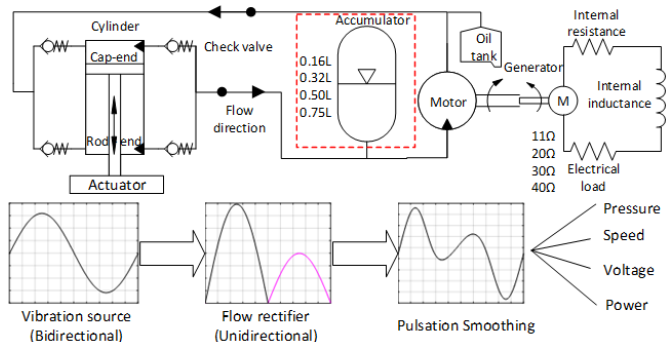
Figure 1. Schematic view of the design concept for a regenerative shock absorber system.